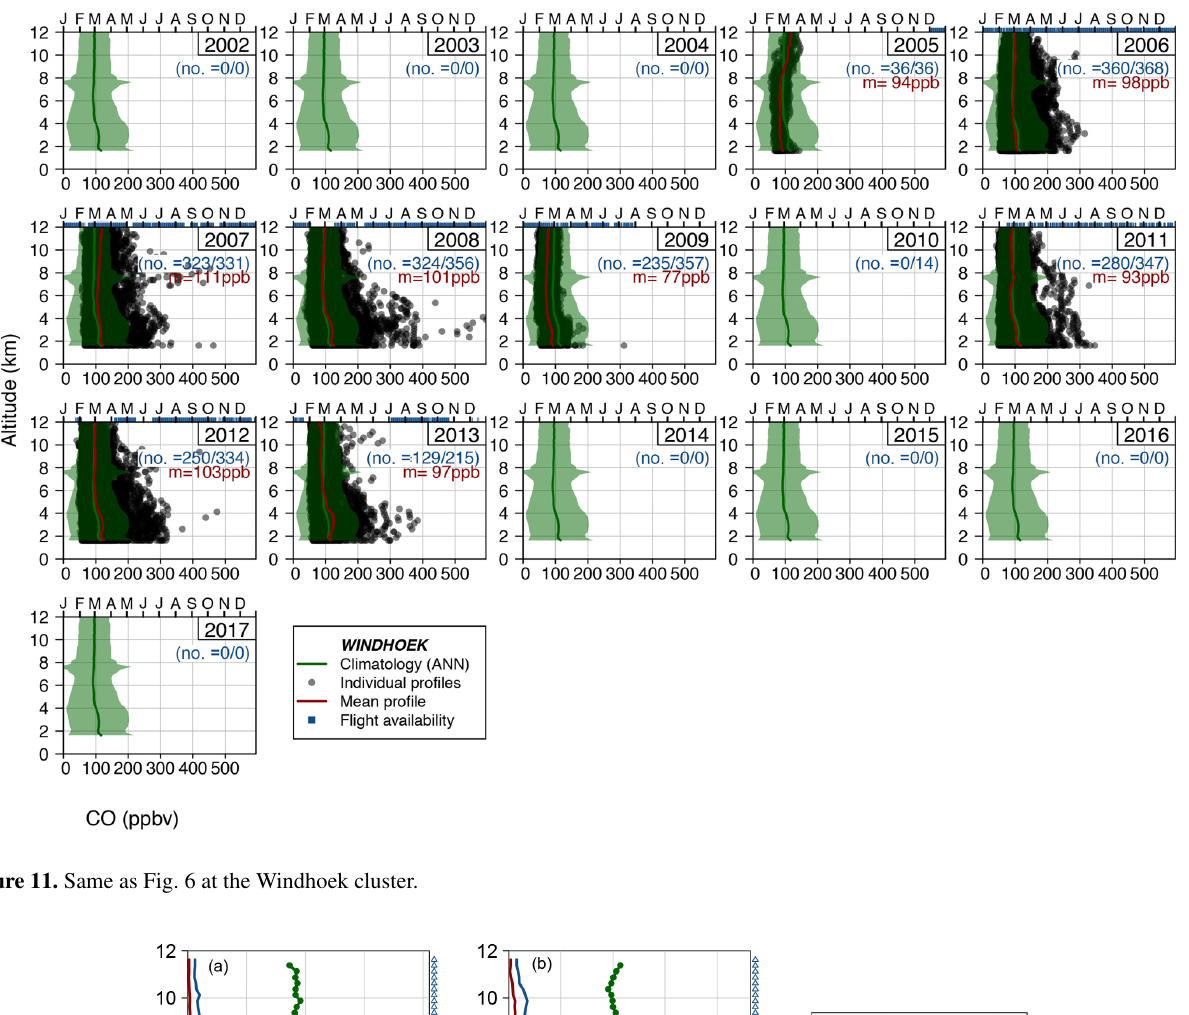
Figure 11. Same as Fig. 6 at the Windhoek cluster.